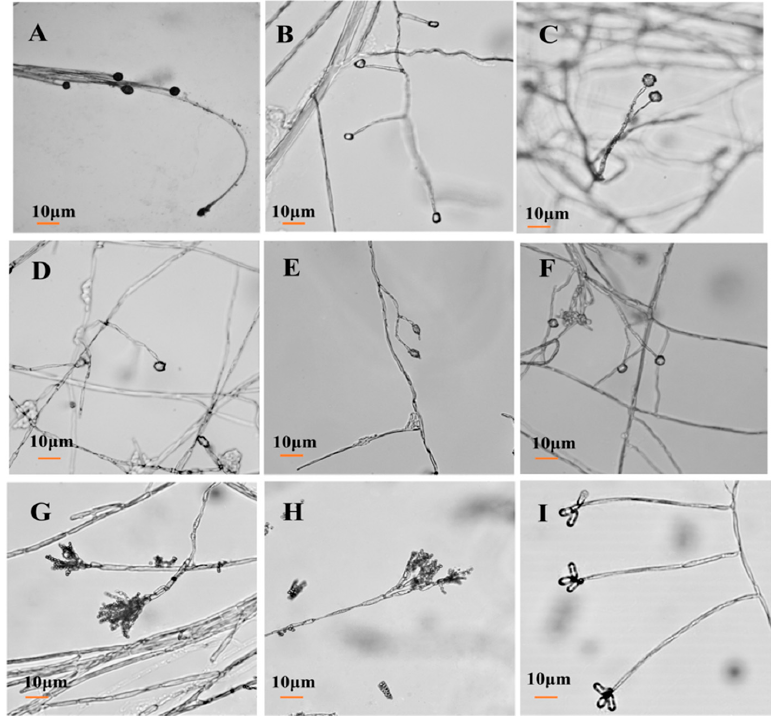
Figure 4. Morphology of conidiophore of isolates from C. pilosula with postharvest disease dur- ing different storage stages. ( A ) Actinomucor elegans ; ( B ) Mucor hiemalis ; ( C ) Fusarium acuminatum ; ( D ) Fusarium equiseti ; ( E ) Fusarium oxysporum ; ( F ) Clonostachys rosea ; ( G ) Penicillium expansum ; ( H ) Penicillium aurantiogriseum ; ( I ) Trichothecium roseum